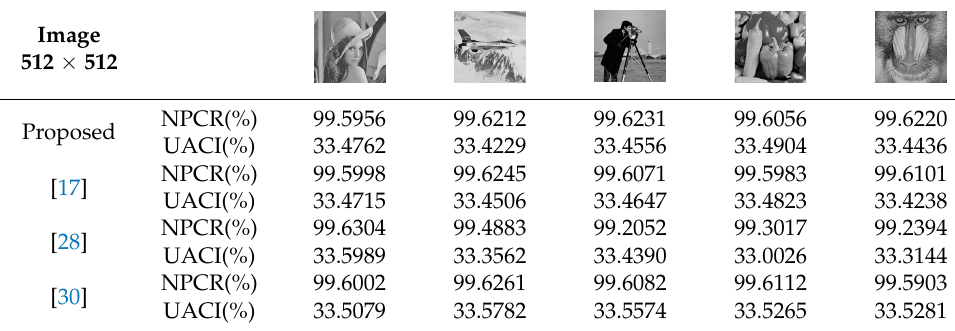
Table 6. Comparison of information entropy. Table 7. Comparison of NPCR and Table 7. Comparison of NPCR and UACI. Table 7. Comparison of NPCR and UACI. Table 7. Comparison of NPCR and UACI. Table 7. Comparison of NPCR and UACI.